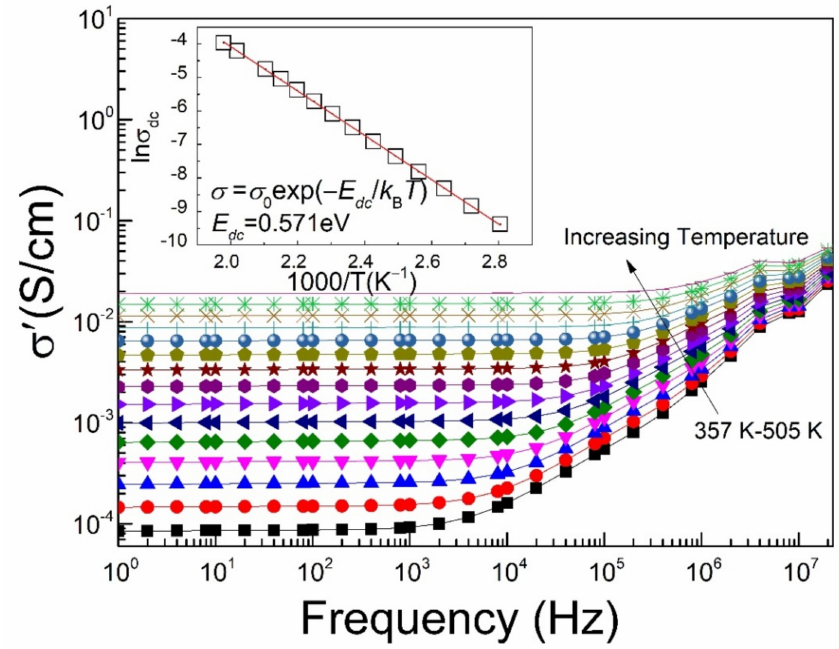
Figure 9. Frequency dependence of ac conductivity in La 2/3 Cu 3 Ti 4 O 12 ceramics from 357 K to 505 K. The inset shows the linear dependence of extrapolated dc conductivity with temperature. According to IBLC electrical model, the imaginary part of impedance Z (cid:48)(cid:48) can be expressed as a function of